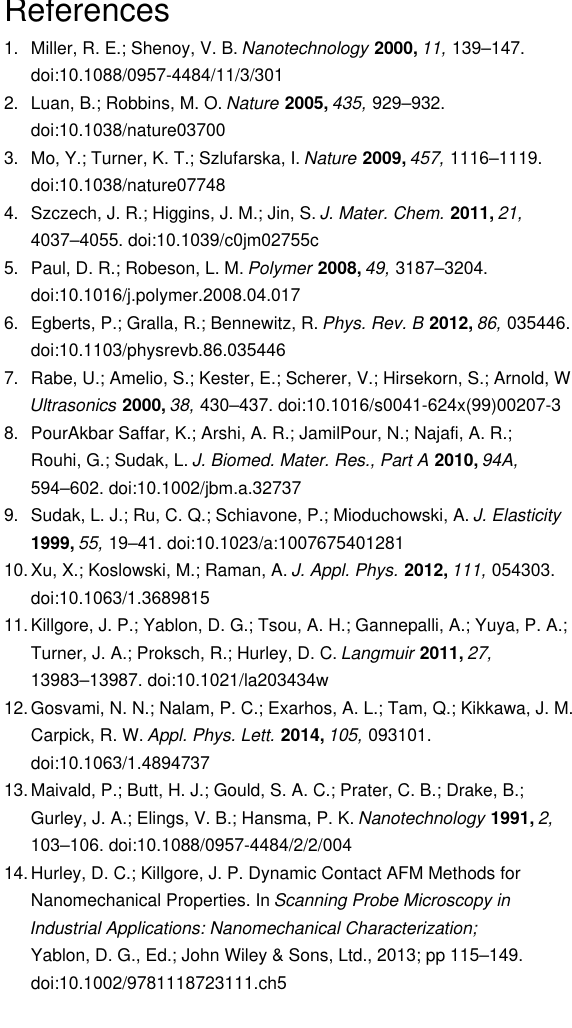
Figure 12: The elastic modulus map according to the grid pattern in four lines, where each line includes 64 rows of static indentation over the HOPG surface.